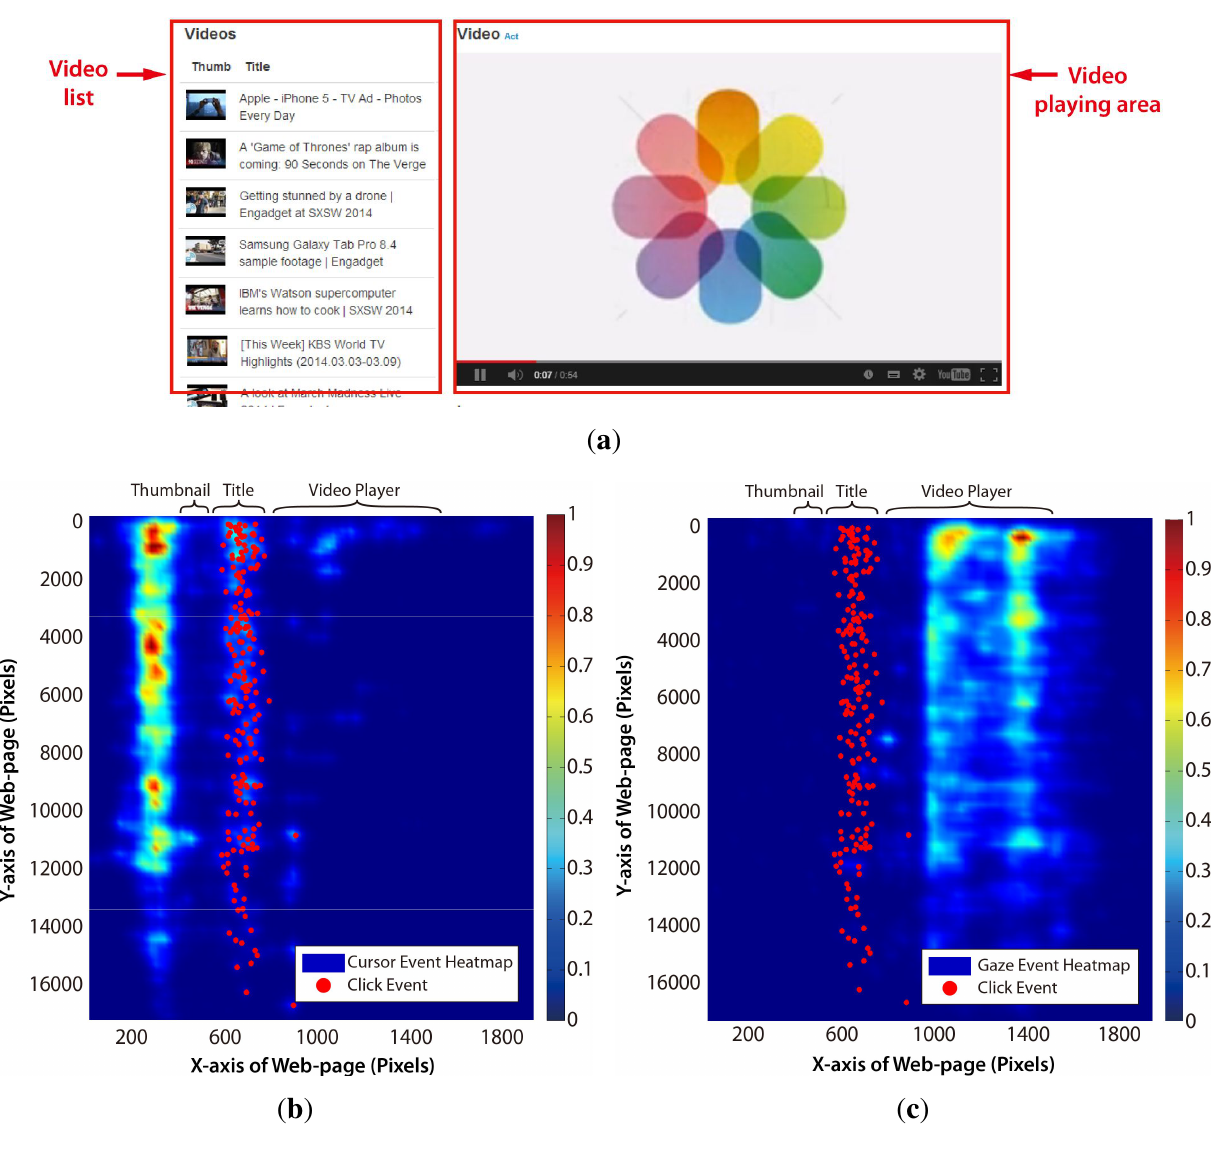
Figure 3. ( a ) A video website layout; ( b ) mouse event pattern of the video website used; ( c ) gaze event pattern of the video website used. Table 1. Summarized horizontal event